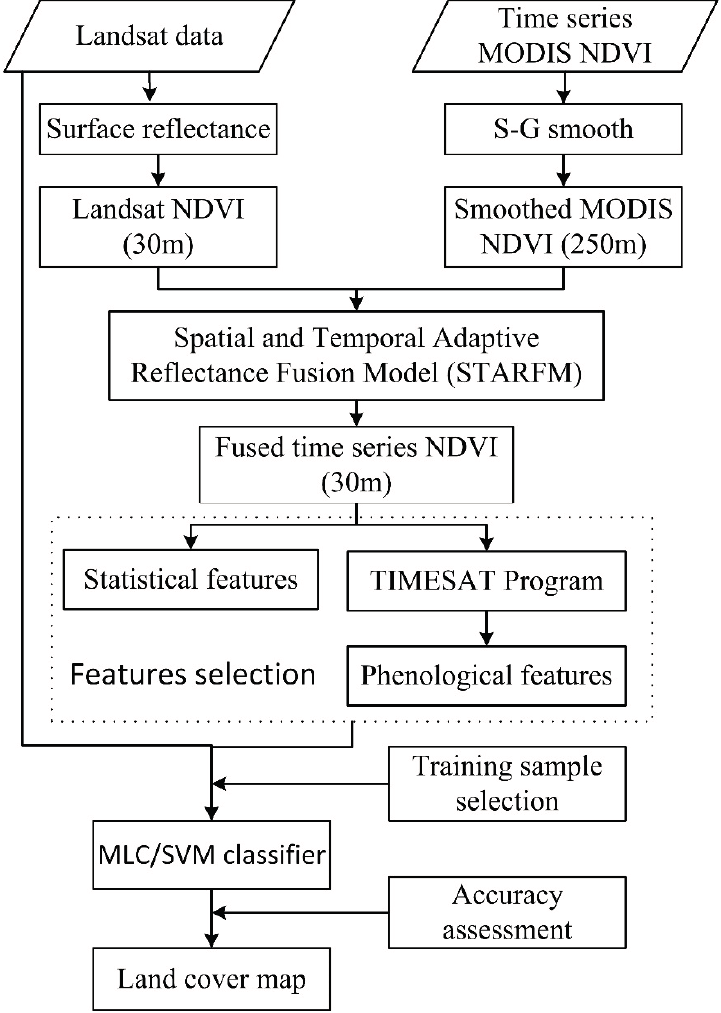
Figure 2. The flowchart of land cover classification of Landsat data with phenological features extracted from time series MODIS NDVI